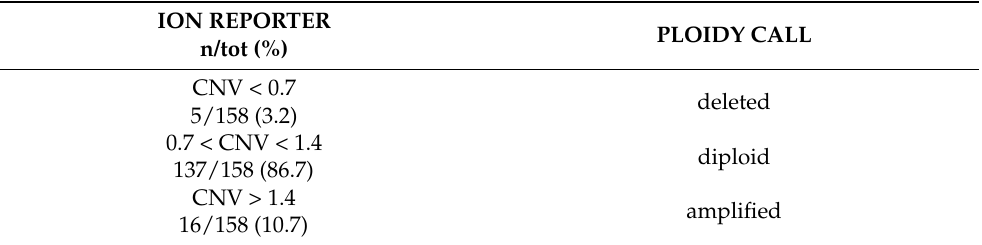
Table 2. Identification of deleted, diploid and amplified cases according to Ion reporter CNV categories.